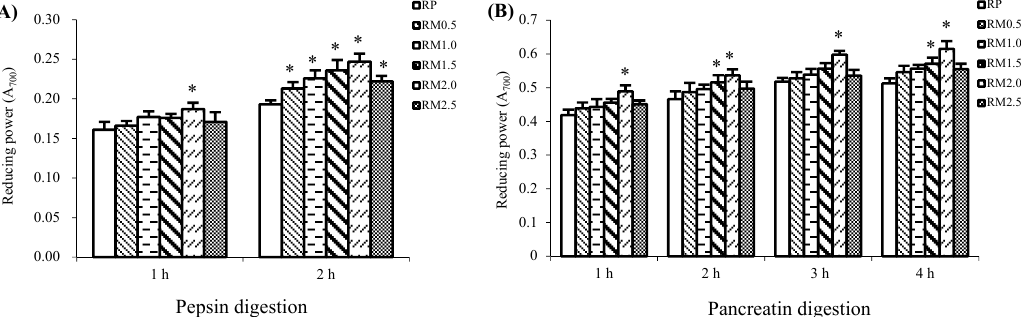
Figure 4. Reducing power of rice protein (RP) and methionine added to rice protein (RM) hydrolysates during in vitro digestion with pepsin ( A ) and pancreatin ( B ). Values are the means ± SEM ( n = 3). * p < 0.05, in comparison with RP.